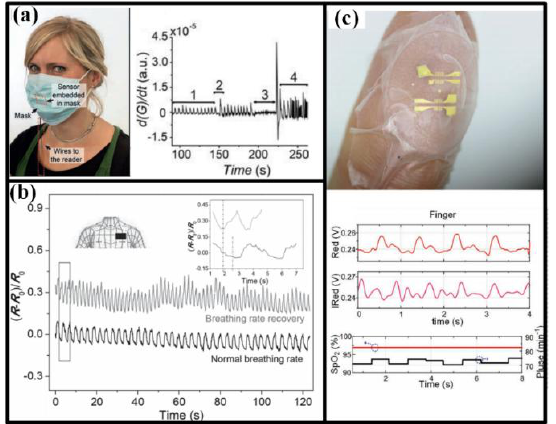
Figure 4. Detection of breath and SpO 2 : ( a ) Detecting breath with a sensor embedded in mask, and the curve shows the results under normally breathing (1), taking a deep breath (2), paused (3) and randomly breathing (4); ( b ) Detecting breath with a strip sensor worn in the chest; ( c ) Detecting the SpO 2 with a sensor attached on fingertip. Reproduced from [5] with permission of WILEY. Reproduced from [7] with permission of WILEY. Reproduced from [79] with permission of WILEY.